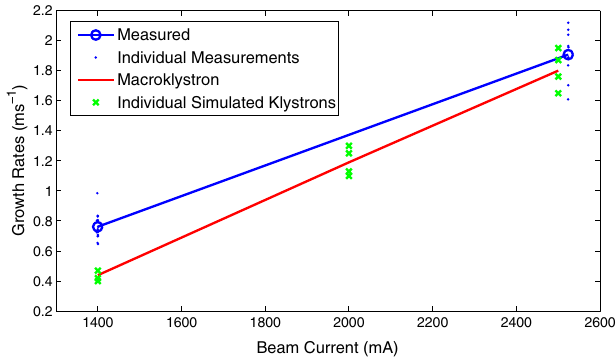
FIG. 6. (Color) Measured and simulated growth rates for the LER (simulated for each station as well as the macroklystron). The most unstable mode is (cid:1) 3 .